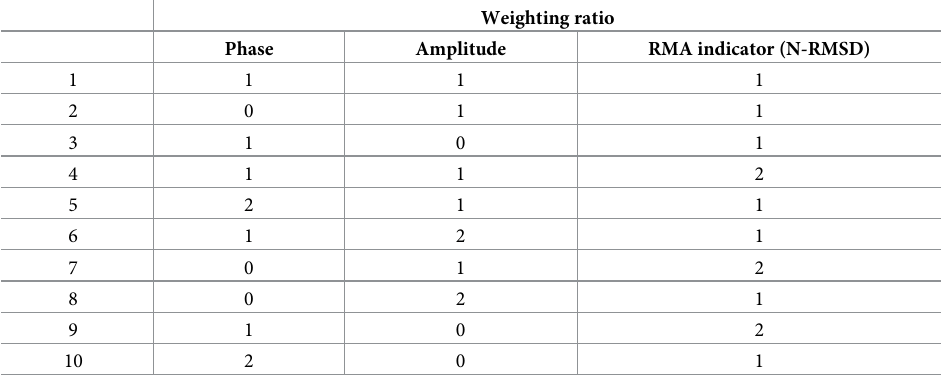
Table 7. Ratio values for the configuration of each objective information for 4DCT sorting in the proposed Amp- sim-w